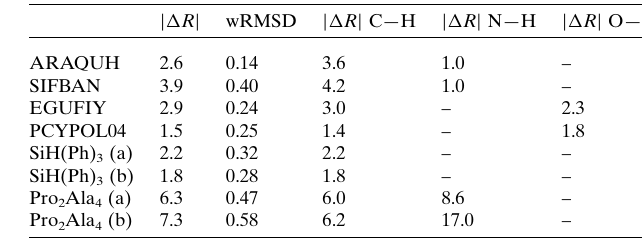
Table 5 Discrepancies between HAR with and without transferability applied.